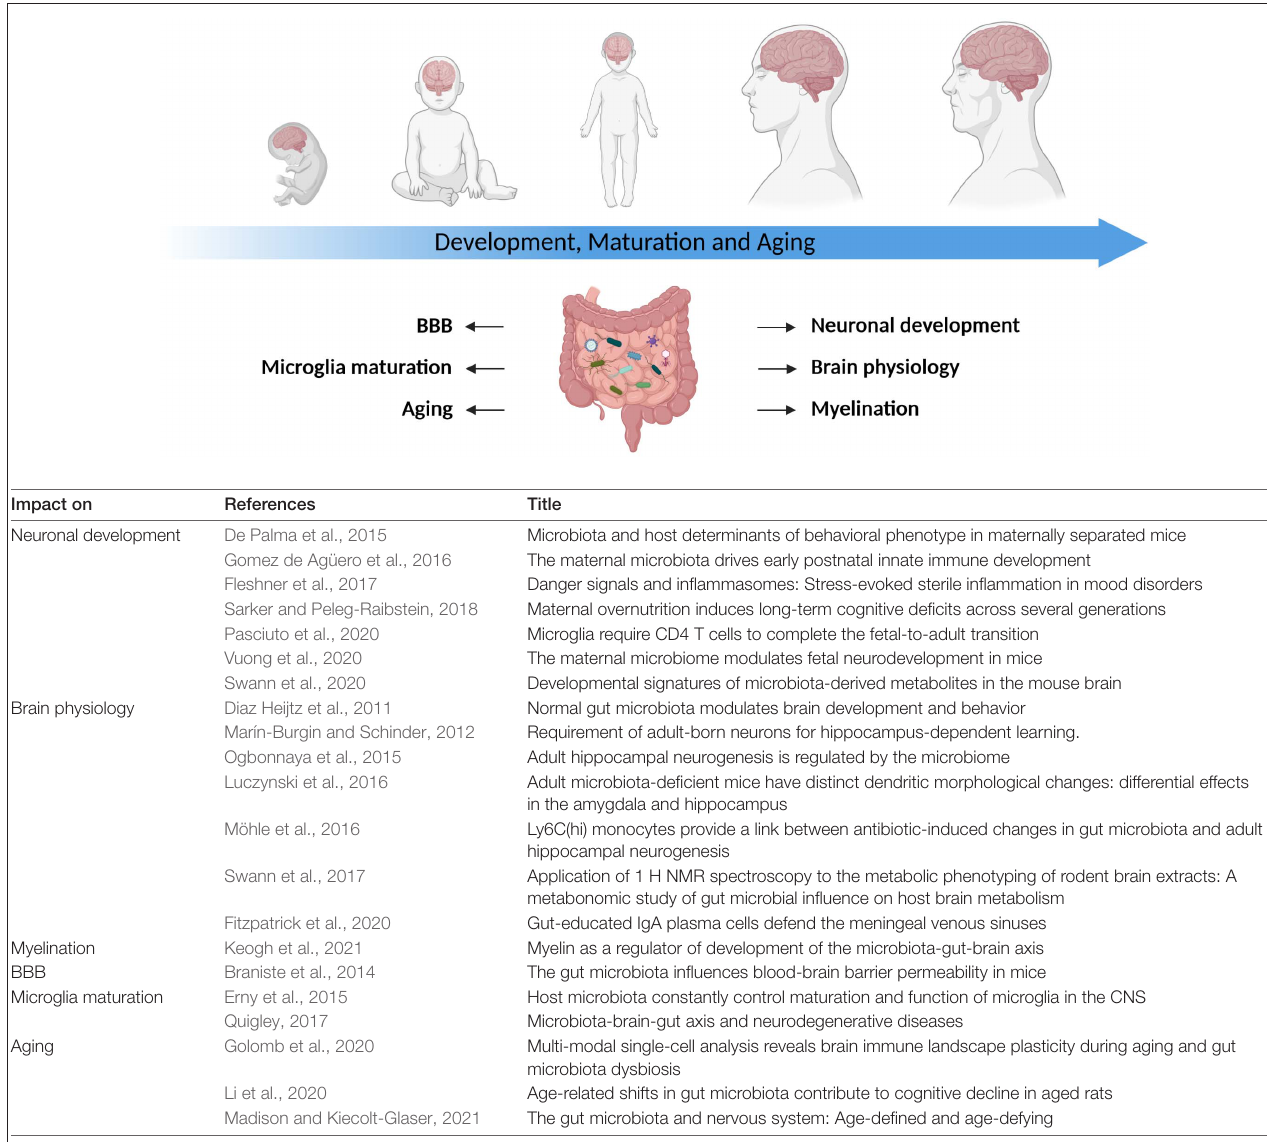
FIGURE 1 | The gut microbiota modulates the development, maturation, and aging of the CNS. The gut microbiota plays a pivotal role throughout all stages of life. It impacts brain physiology, myelination, blood–brain barrier function (BBB) as well as microglia maturation and contributes to the process of aging. Table lists corresponding references, all studies are primarily based on rodent